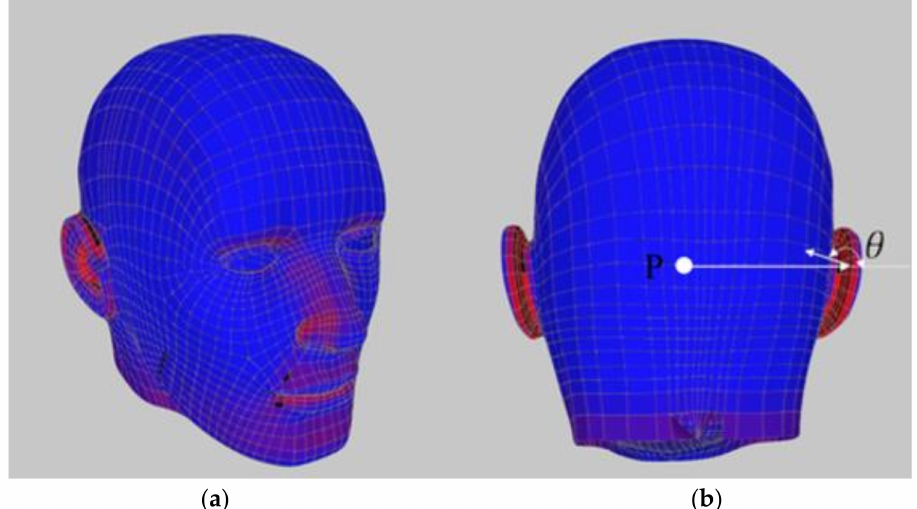
Figure 8. ( a ) Model visualizing the angle (0 to 180 ◦ ) with respect to the target shape plane at a specific point P (x, y, z) with color variations (blue to red). ( b ) Calculation of the expressiveness function (F) for one